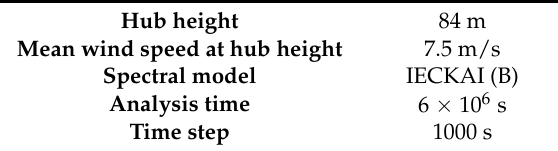
Figure 4. Wind data series generated with TurbSim tool.